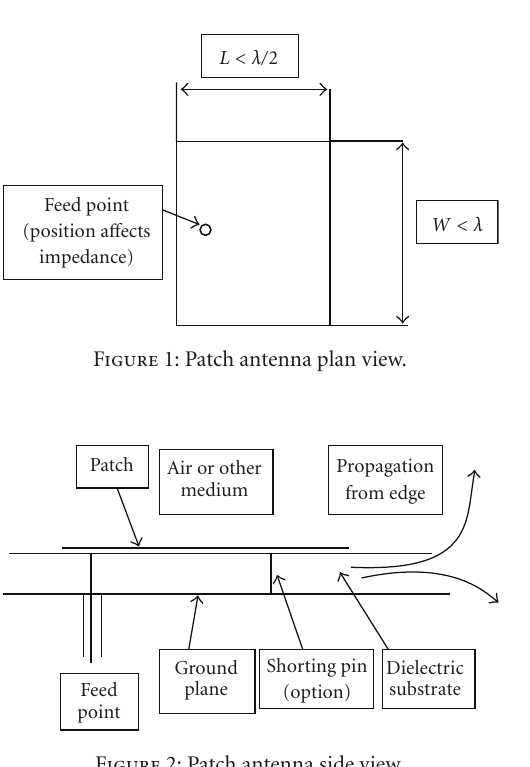
Figure 2: Patch antenna side view.